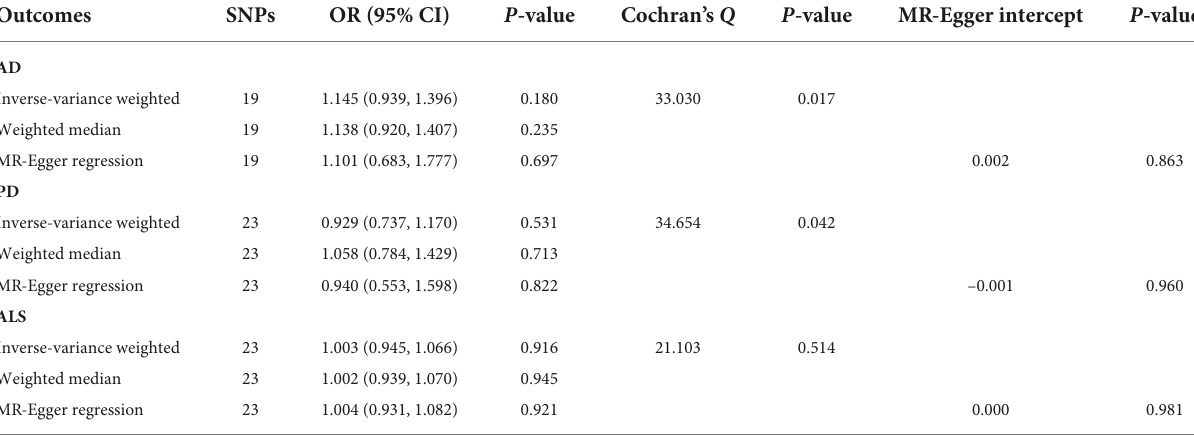
TABLE 1 Mendelian randomization analyses of circulating glycine levels on three neurodegenerative